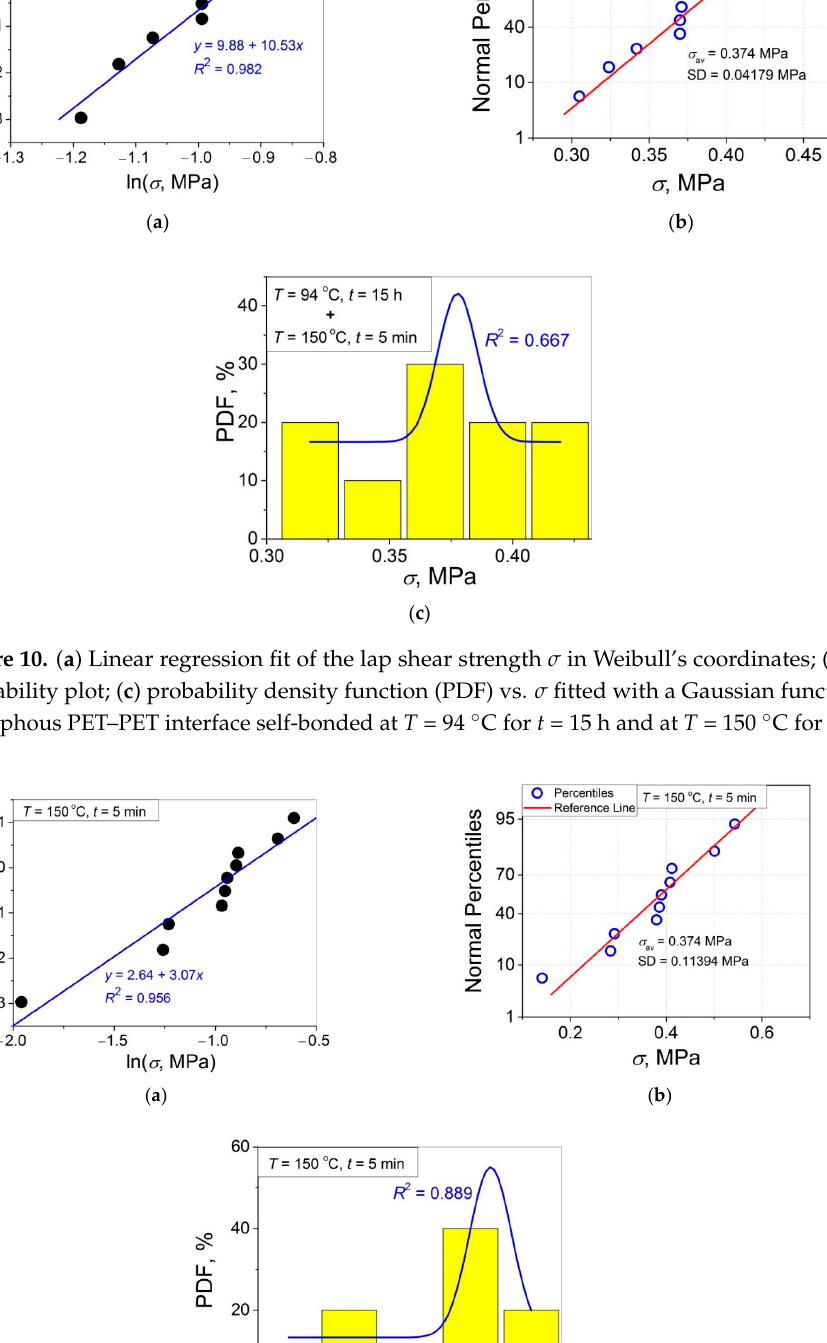
Figure 9. ( a ) Linear regression fit of the lap shear strength σ in Weibull’s coordinates; ( b ) normal probability plot; ( c ) probability density function (PDF) vs. σ fitted with a Gaussian function for an amorphous PET–PET interface self-bonded at T = 94 °C for t = 4 h and at T = 150 °C for t = 5 min.